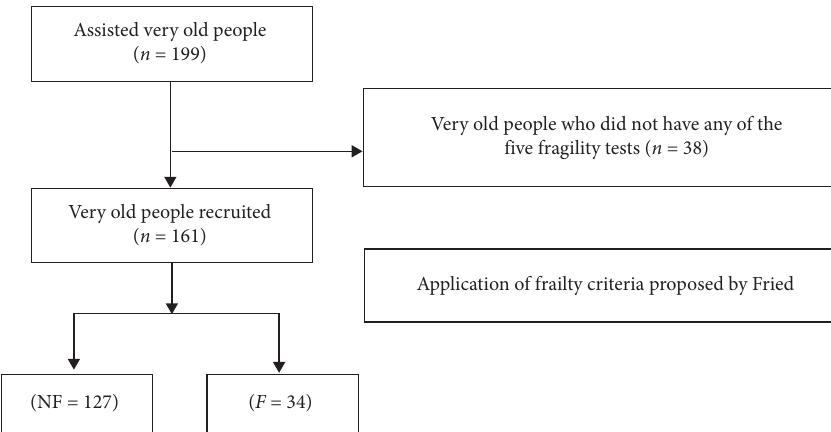
Figure 1: A schematic drawing of the sample. NF � nonfrail and F �